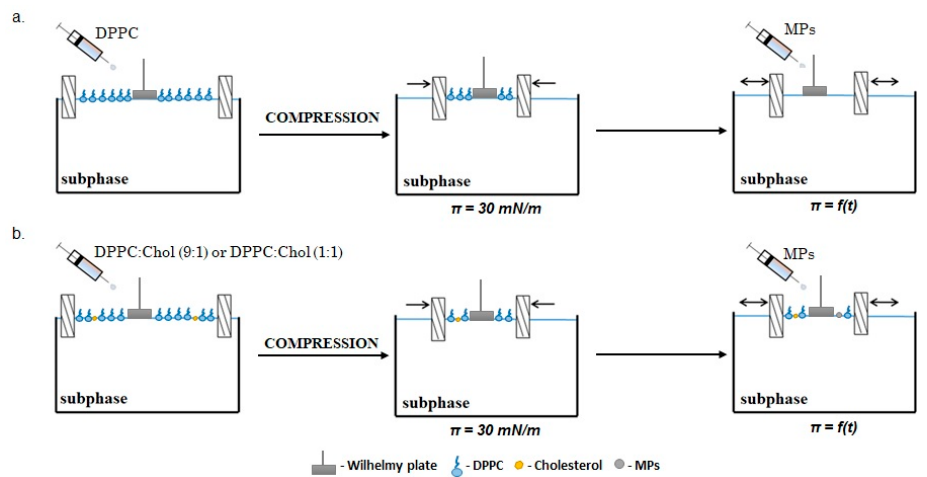
Figure 7. The schematic idea of relaxation experiments: ( a ) monocomponent membrane, ( b ) multi- component membrane.